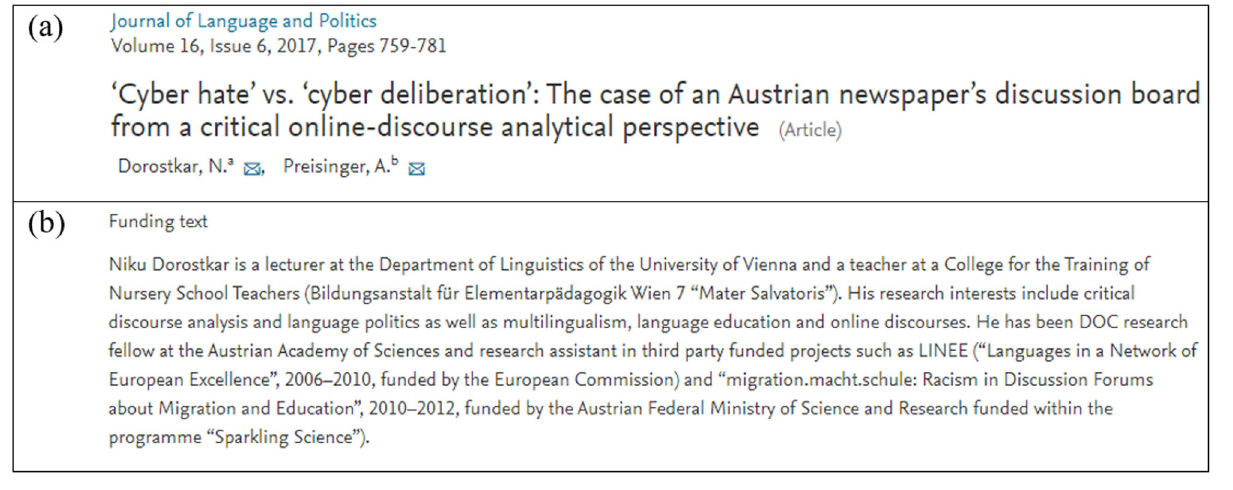
Fig. 2 Example of bibliographic reference in Scopus with author bio in the Funding fi eld. a Bibliographic reference in Scopus. b Funding fi eld in the Scopus record corresponding to an author bio, possibly listed automatically because of the inclusion of the term “ funded ” . Table 1 Projects in the social sciences and humanities funded under FP6.